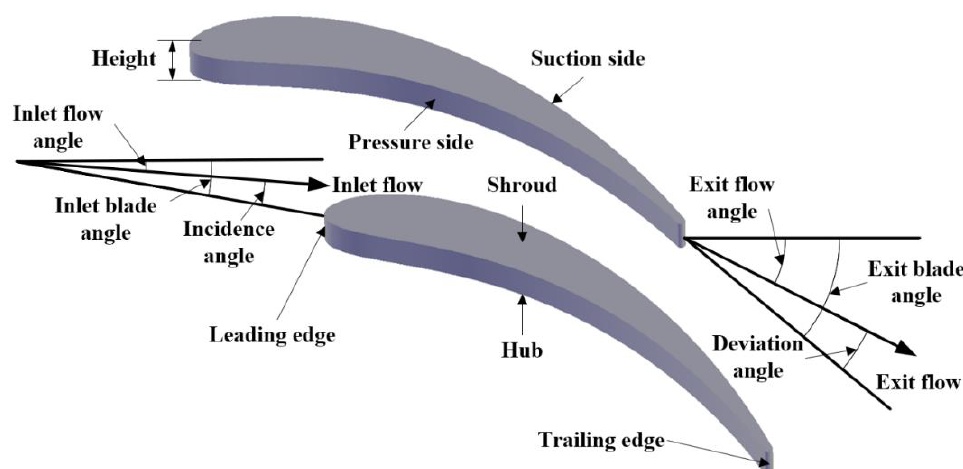
Figure 4. Blading terminology of a radial outflow turbine [3].